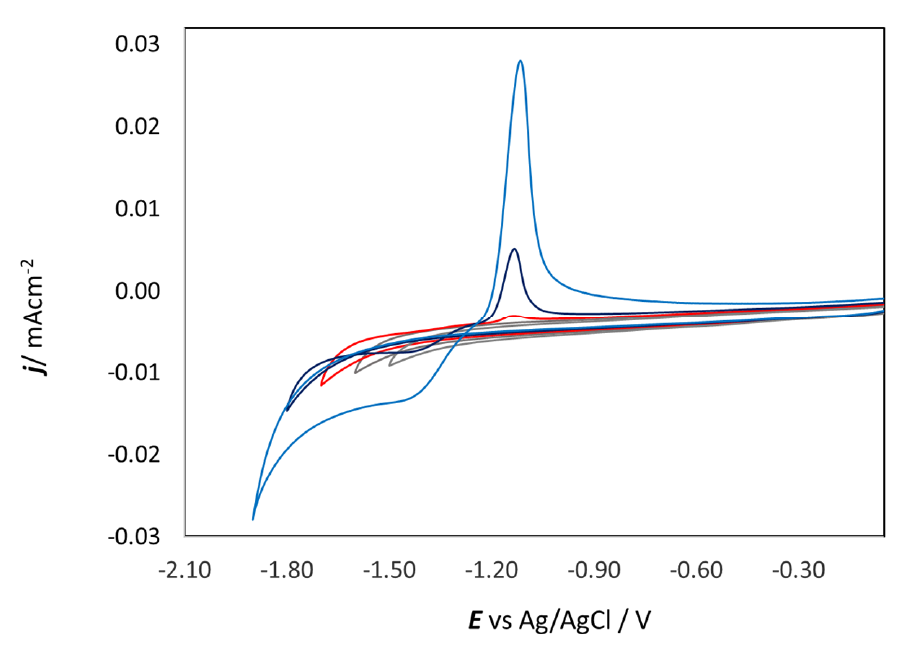
Figure 3. Cyclic voltammograms of 0.3 M ZnSO 4 in ChU with GC electrode at 25 °C and 10 mV s −1 and different cathodic vertex potentials.